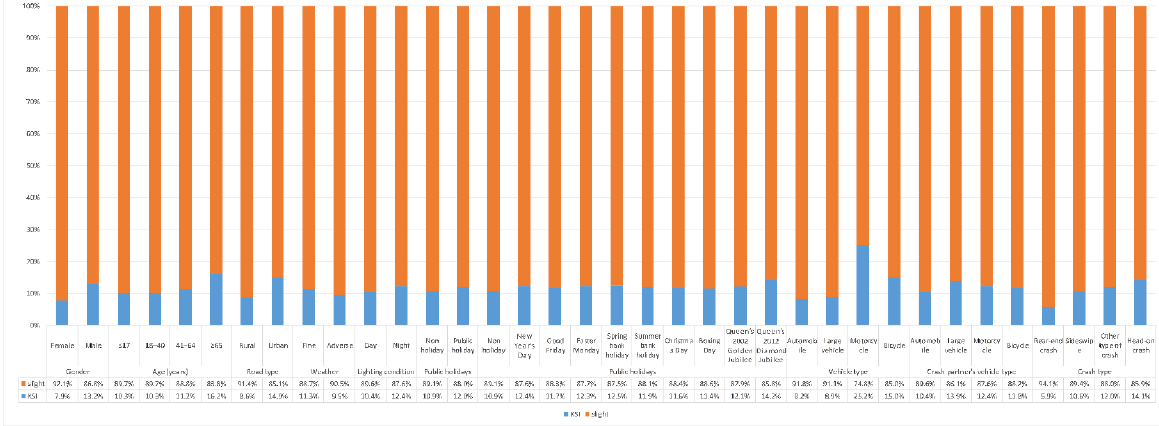
Figure A1. Distribution of casualties’ characteristics from the UK STATS19 data [24].